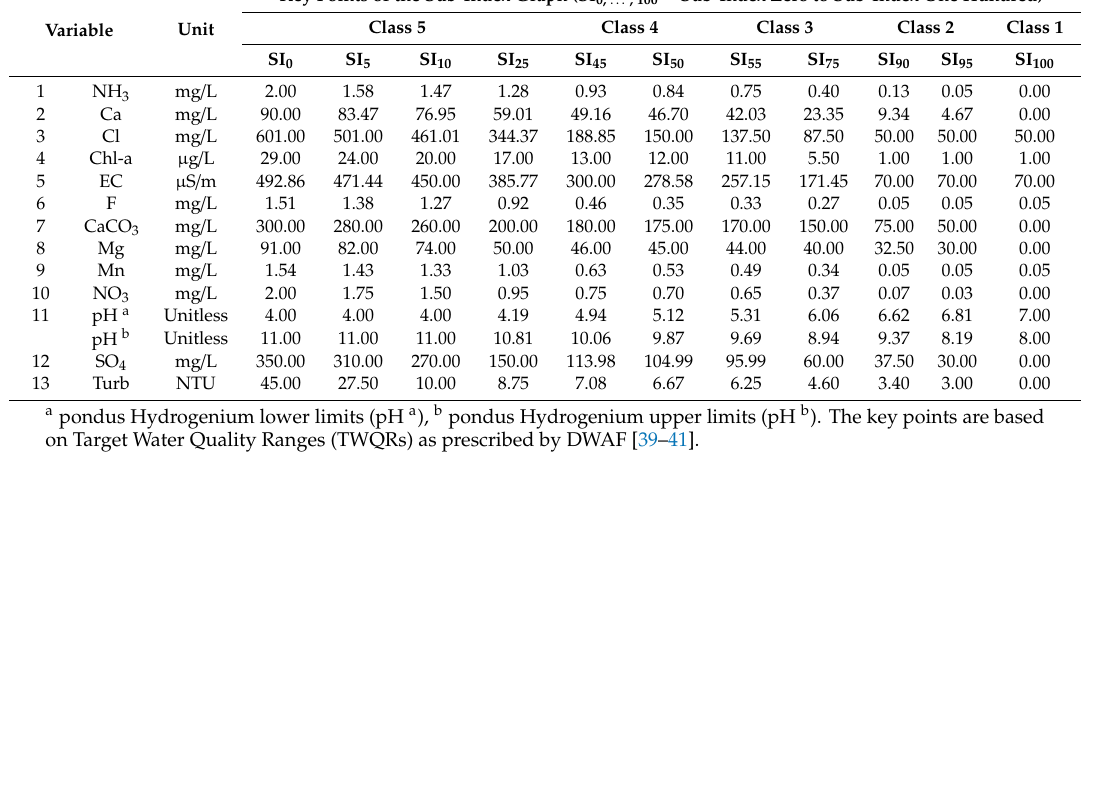
Table 4. Range of water quality parameters and their key points defined for sub-index rating curves.